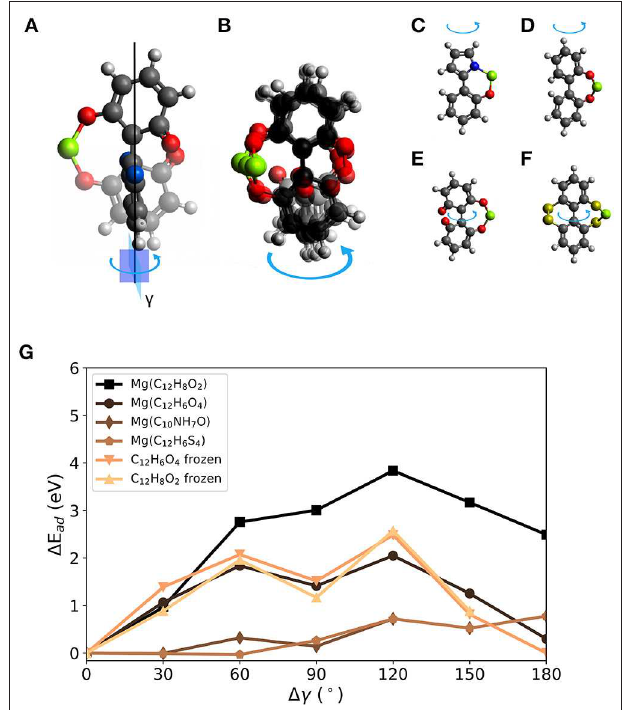
FIGURE 5 | Rotation of the dihedral angle γ in biphenyl-derived molecules with carbonyl as redox-active group. (A) 1,1 ′ -Bi(1,4-cyclohexadiene-1-yl) -2,2 ′ ,6,6 ′ -tetrone (BCT) with chosen rotational axis (black vertical line) and angle (arrow). The initial structure is given with red O atoms and the final position with a changed dihedral angle between 6-membered rings indicated by blue O atoms on the ring. (B) Superposition of investigated rotated structures of BCT 0 ◦ to 180 ◦ in steps of 30 ◦ . Overview of molecules investigated for dihedral strain design: (C) C 10 NH 7 O, (D) C 12 H 8 O 2 (BipO2), (E) BCT, and (F) C 12 H 6 S 4 . (G) Change of interaction strength with a Mg atom for different dihedral angles γ